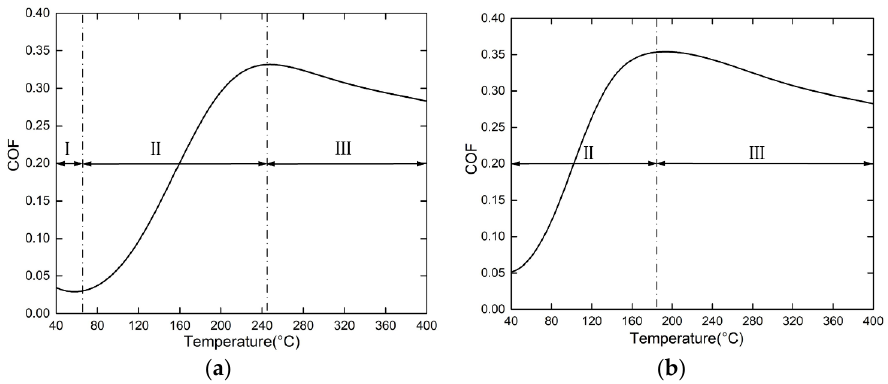
Figure 4. Influence of surface temperature on COF. ( a ) 1500 rpm; ( b ) 300 rpm. As the temperature increases in stage Ⅱ , the contact state of the friction pair changes from mixed lubrication to boundary lubrication, and finally enters the dry friction state, which is consistent with the Stribeck curve. Meanwhile, the thickness of the ATF film gradually reaches the minimum, which is much smaller than the height of asperities [30]. Accordingly, asperity contact is dominant, which does not simply bring about a dramatic increase in COF but also promotes the decomposition and oxidation of ATF. When the friction pair is in the dry friction state, COF reaches the highest value at about 0.35 and is temporarily stable. Subsequently, thermal decay occurs and becomes increasingly worse in stage III , leading to a significant decrease in COF. Moreover, as the friction material begins to soften, adhesive friction plays a leading role and is accompanied by the peeling of friction material. Therefore, not only is the wear of friction material apparently accelerated but the clutch service life is also significantly shortened. Such a phenomenon